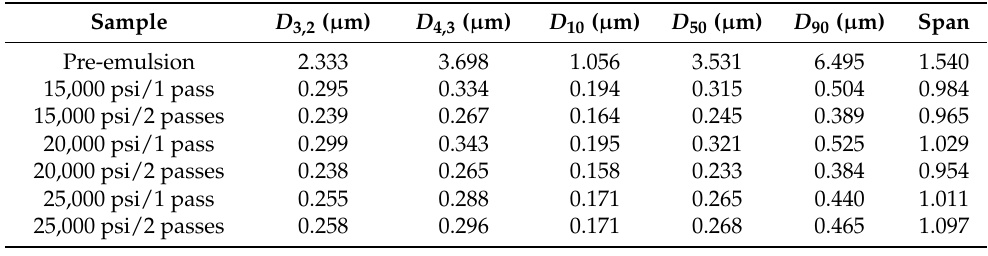
Table 1. Sauter diameter, volumetric diameter, D 10 , D 50 , D 90, and span values for linseed oil